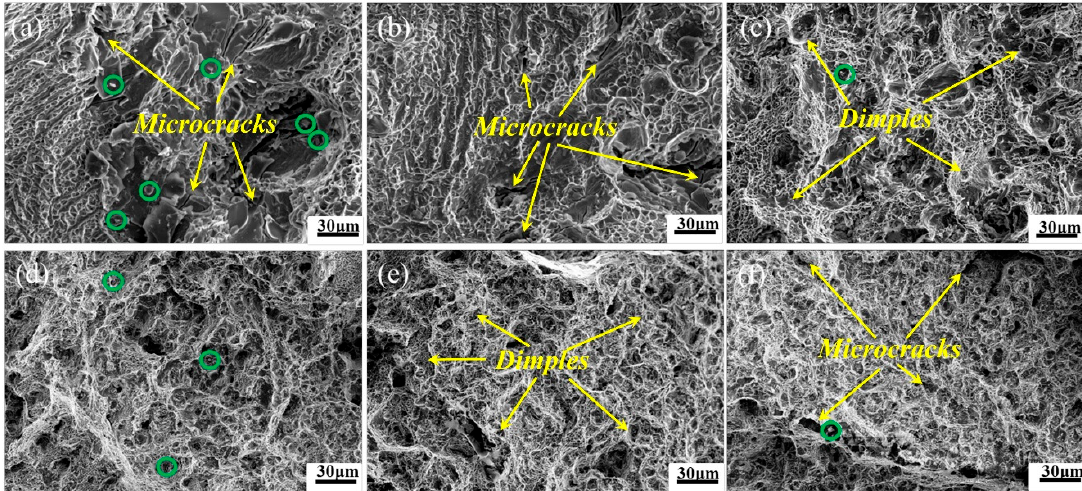
Figure 6. Room-temperature tensile fracture morphologies of CHP steel ( a , b , c ) and SHPP steel ( d , e , f